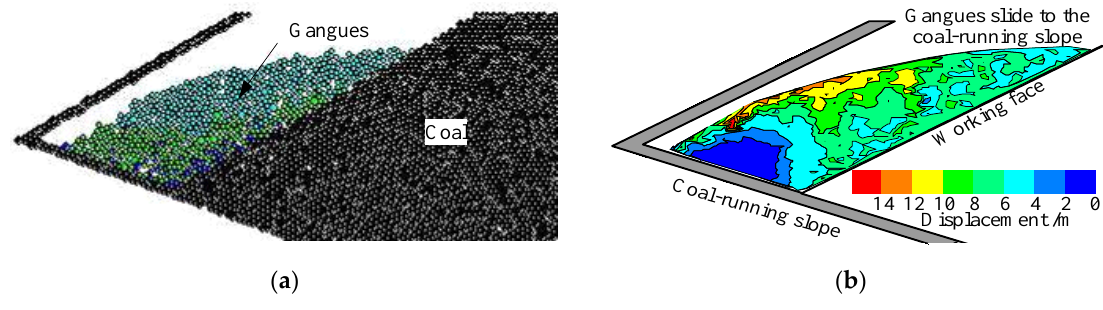
Figure 6. Gangue backfilling characteristics at the landslide stage: ( a ) backfilling form and ( b ) displacement distribution.